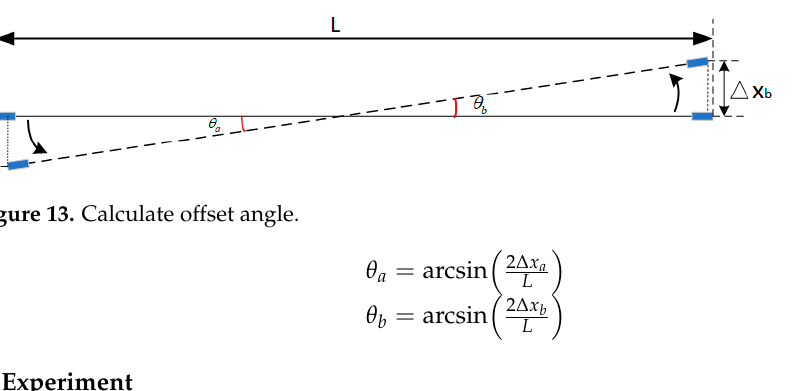
Figure 13. Calculate offset angle.